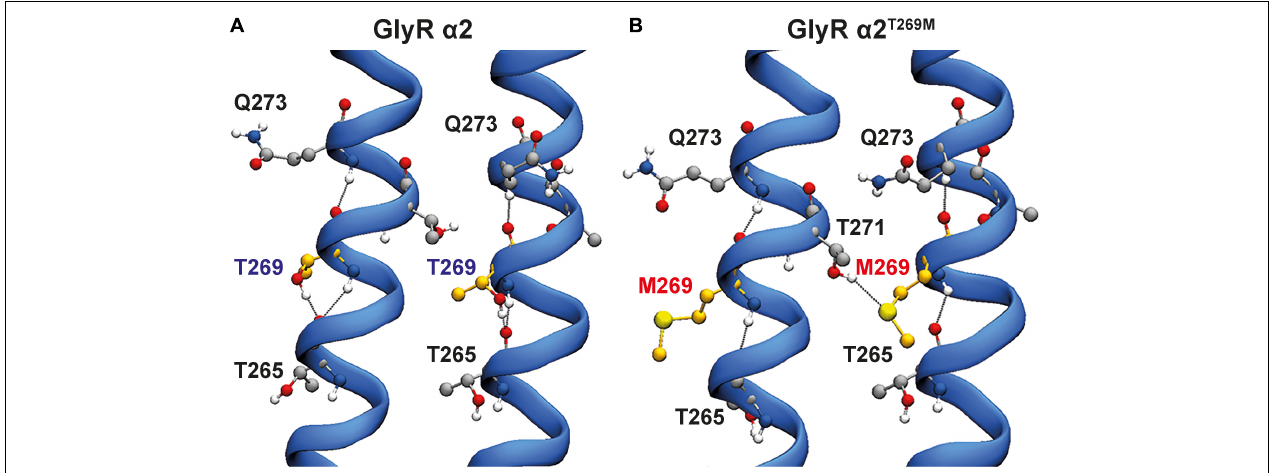
FIGURE 4 | Hydrogen bonding interactions for wild-type GlyR α 2 and GlyR α 2 T269M variants. Two adjacent M2 helices are shown and surrounding amino acids showing interactions between adjacent M2 domains. (A) In the wild-type GlyR α 2, T269 is stabilized by hydrogen bonds with the adjacent polar residues T265 and Q273 located in the same M2 domain in an arrangement where the side chains are stacked. (B) Conversely, while the larger, non-polar mutant M269 also interacts with T265 and Q273, the longer side-chain forms an additional interaction with T271 in the M2 domain of the adjacent GlyR α 2 monomer.